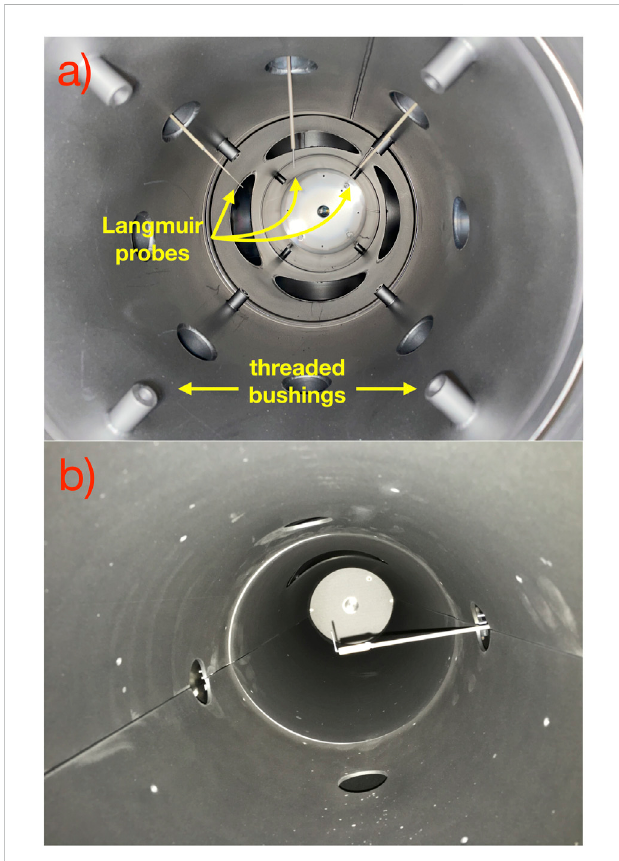
FIGURE 2 Photographs of the interior of the vacuum vessel of GyM w/o (A) andw/ (B) theW-coatedliner.PicturesweretakenfromtheCF100quick access door of sector 4, pointing the camera to sector 1. Different Langmuir probes may be seen in the two fi gures. The threaded bushings supporting the liner are also indicated in (A)